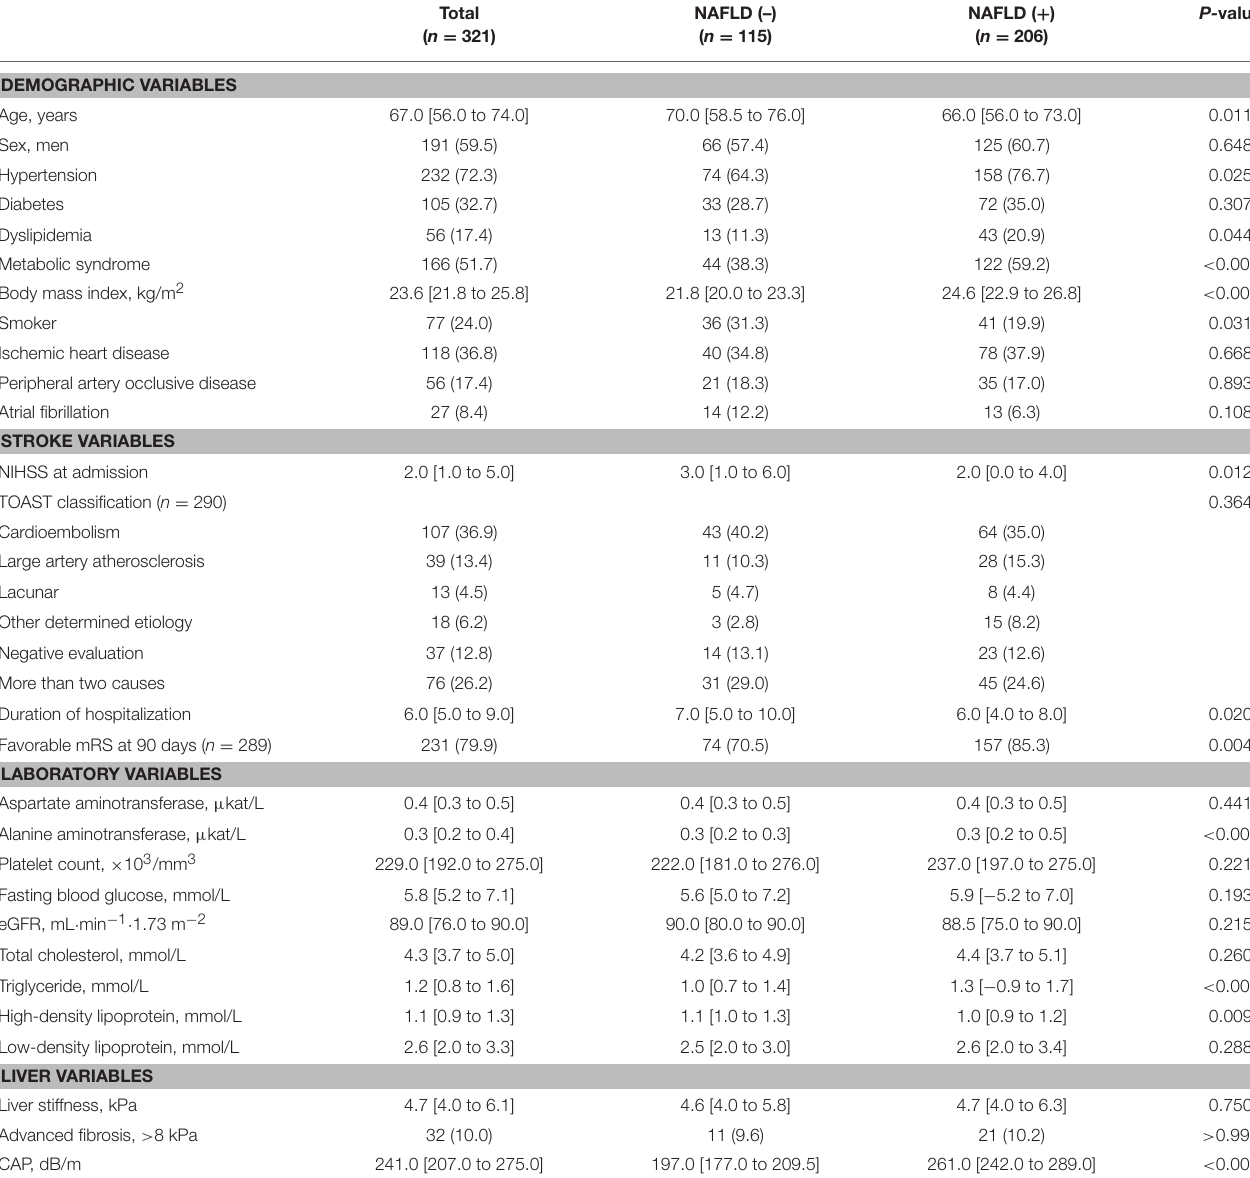
TABLE 1 | Demographic characteristics of study patients according to the presence of NAFLD.